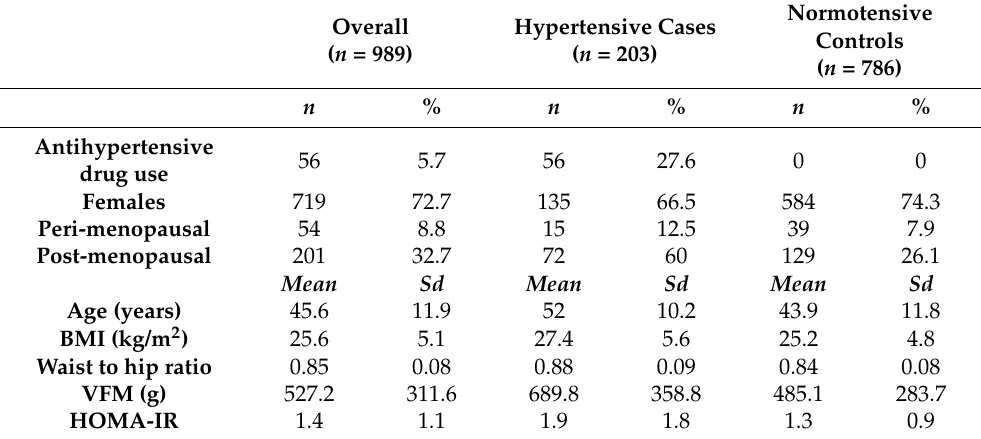
Table 1. Demographic characteristics of the study population overall and by hypertension